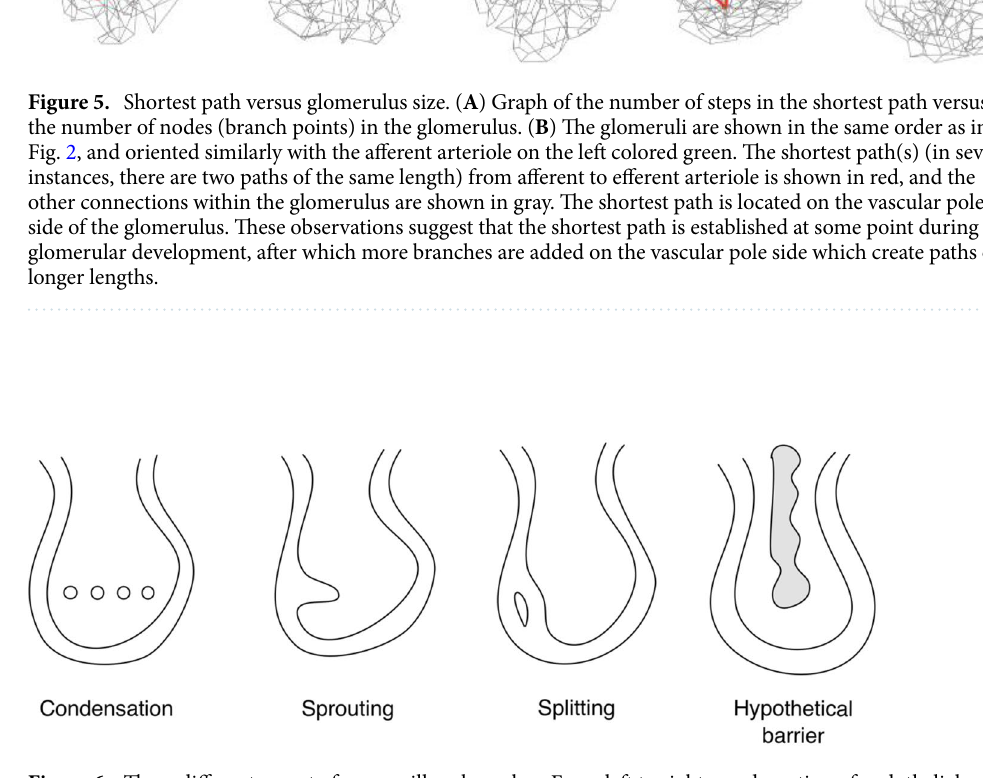
Figure 6. Three different ways to form capillary branches. From left to right: condensation of endothelial cell precursors, also called vasculogenesis; sprouting from pre-existing capillary; Widening of a capillary region following by longitudinal splitting. Far right: hypothetical barrier that could prevent formation of capillary branches which would short circuit the